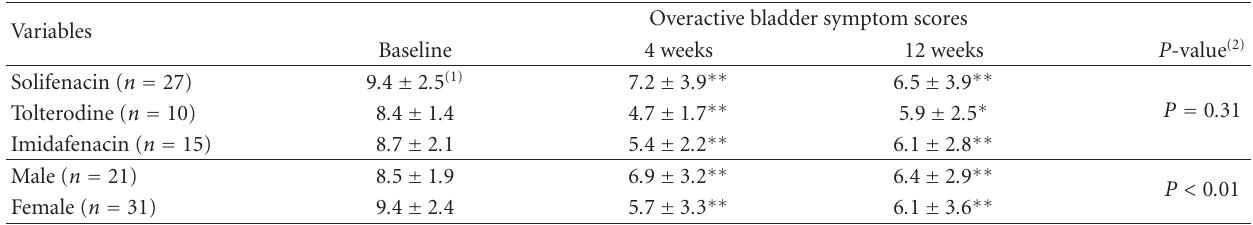
Table 2: Changes in overactive bladder symptoms by previous anticholinergic agent and by gender.